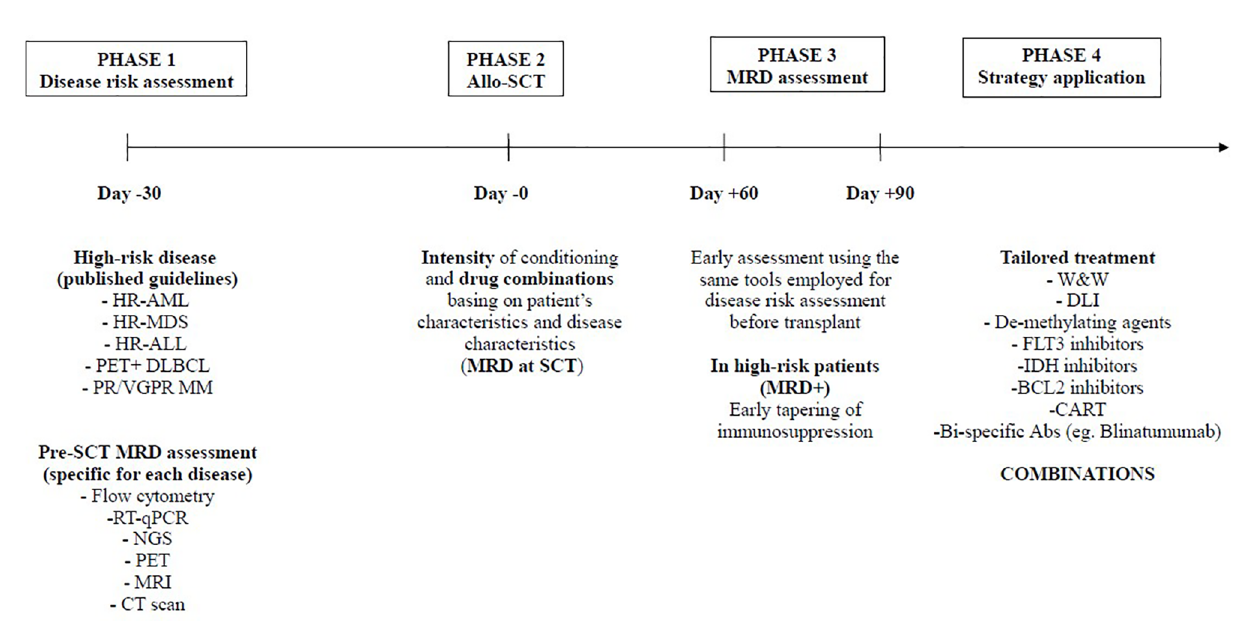
FIGURE 1 | Relapse prevention following